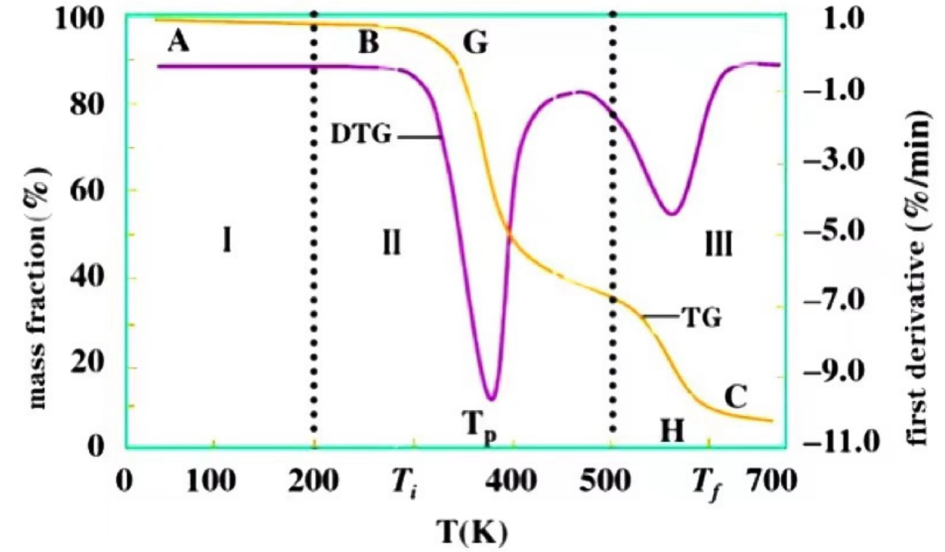
Figure 10. TG and DTG curves of raw cow